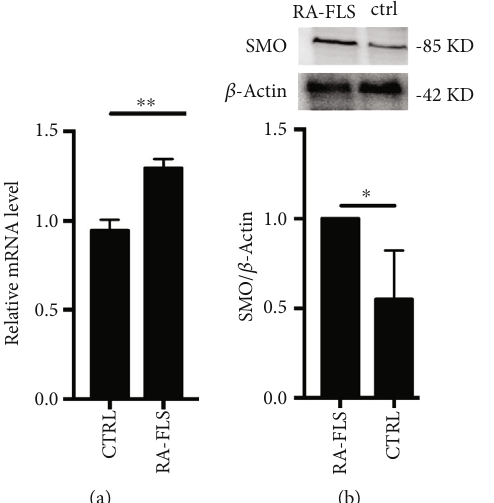
Figure 2: Smo expression was higher in RA patients than in OA patients. (a) The Smo mRNA level in FLS from RA patients was higher than that in FLS from OA patients ( ∗∗ p < 0 : 01 ). (b) Western blot assays demonstrated that the expression of Smo in RA-FLS was also higher than that in OA-FLS ( ∗ p < 0 : 05 ).